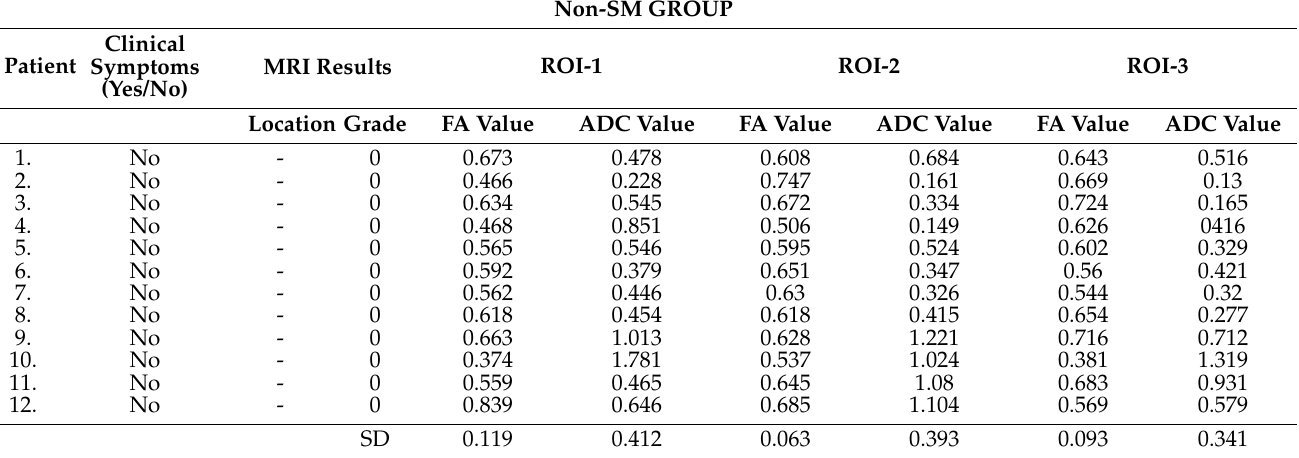
Table 1. Clinical and MRI results of the non-SM group with FA and ADC measurements from ROI-1, ROI-2 and